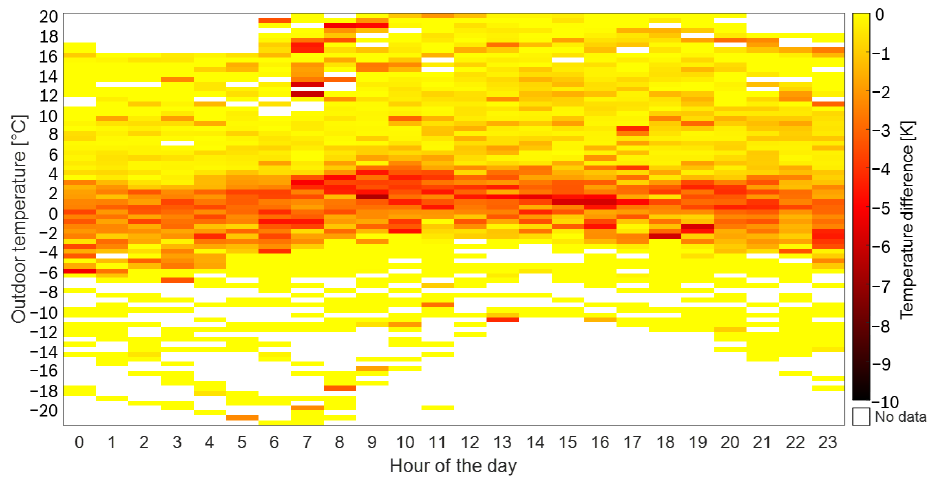
Figure 19. Simulated negative temperature differences of 15-min periods in dependency of the outdoor temperature and time of the day.